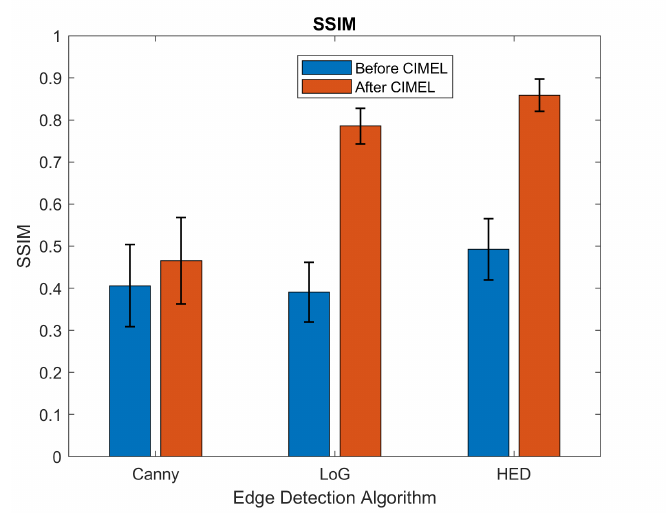
Figure 8. Results of SSIM before and after CIMEL for three edge detection methods.